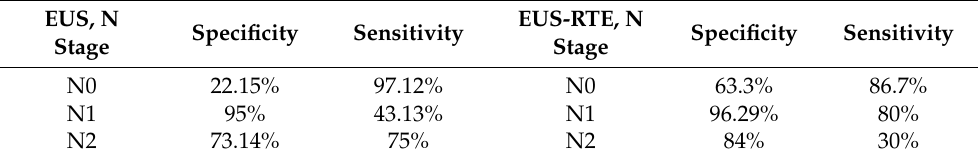
Table 3. Specificity and sensitivity, EUS_N and EUS-RTE_N. EUS, N